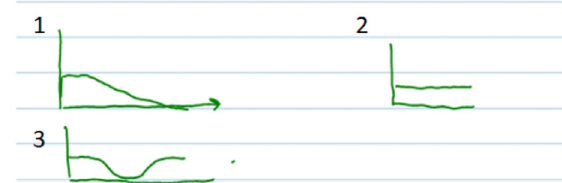
FIG. 5. Three profiles drawn by Beth while answering the prompt about the final concentration profile. The numbers indicate the order in which the plots were drawn. When drawing the second plot, Beth was considering a case in which there were no strings. In the third sketch, Beth said she would not expect the concentration profile to go completely to zero in the middle region despite drawing it that